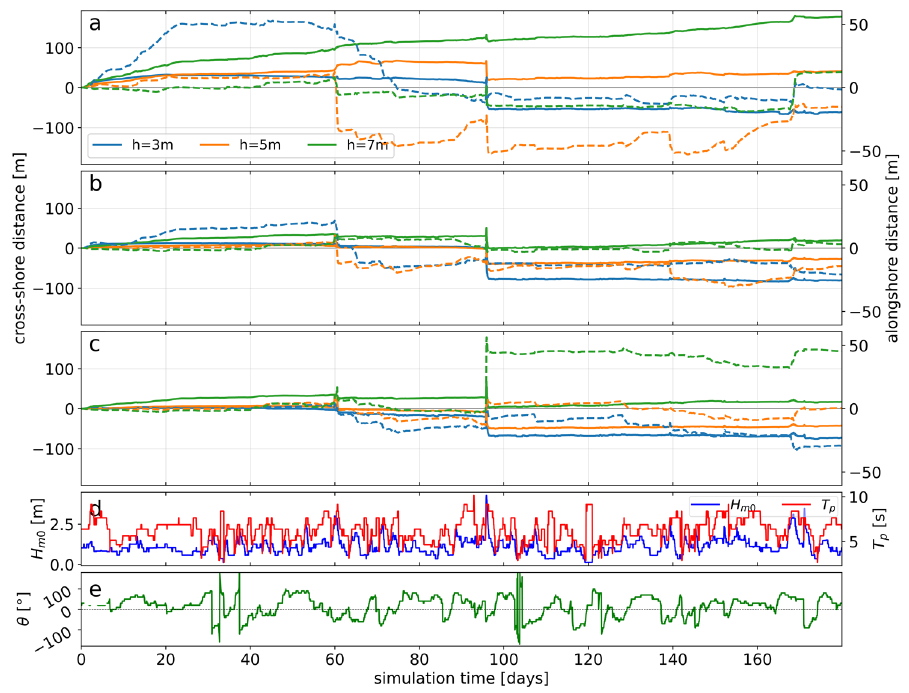
Figure 18. Time series of cross-shore (solid line) and alongshore (dashed lines) displacements of nearshore nourishment sediment for the South Padre Island scenario for 3 m (blue lines), 5 m (orange lines), and 7 m (green) placement depths, respectively. ( a ) Linear berm; ( b ) undulated berm; ( c ) discrete mounds; ( d ) offshore wave height and peak period; ( e ) wave direction relative to shore-normal.